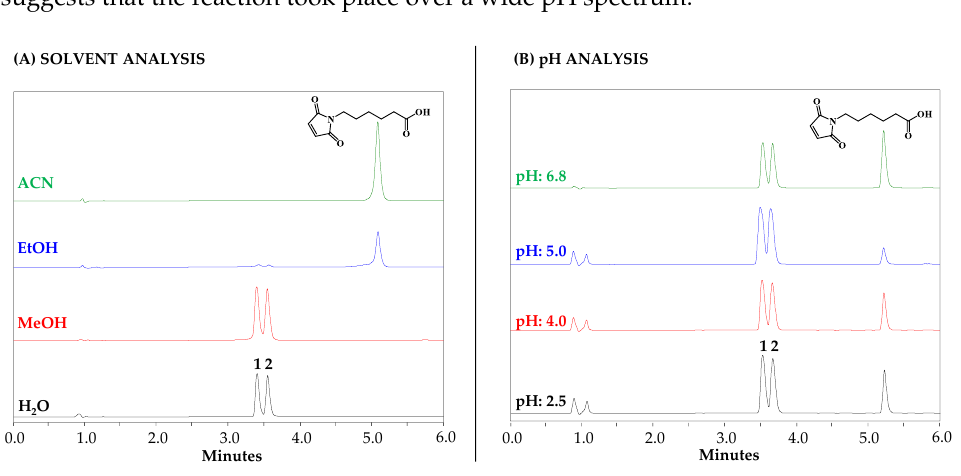
Figure 3. RP-HPLC monitoring of the reaction between Cys and maleimidehexanoic acid (Mhx). ( A ) Reaction in different solvents (H 2 O, MeOH, EtOH, and ACN). ( B ) Reaction in aqueous solution at different pH values: 2.5, 4.0, 5.0 and 6.8. Peaks 1 and 2 correspond to the reaction products.